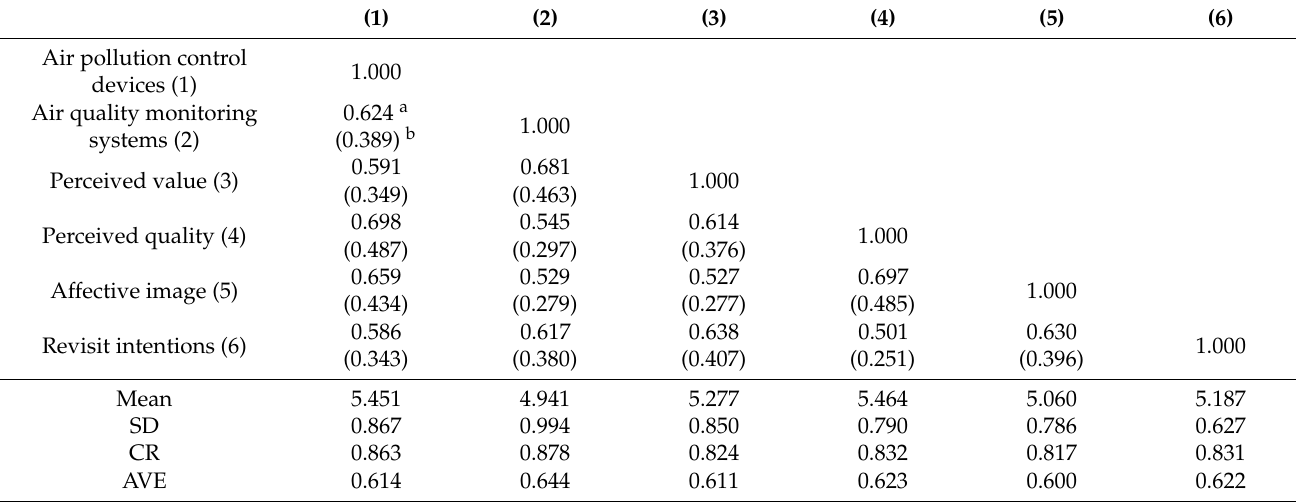
Table 2. Measurement model assessment and